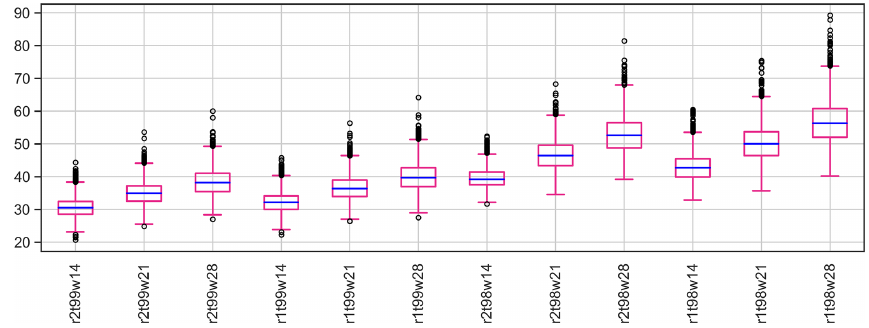
Figure D1. Boxplots of S cl for all catchments and parameter combinations. Boxes extend from the first (Q1) to the third (Q3) quartile values of the data, with a blue line at the median. The position of the whiskers is 1 . 5 · ( Q3 − Q1 ) from the edges of the box. Outlier points past the end of the whiskers are shown with black circles.